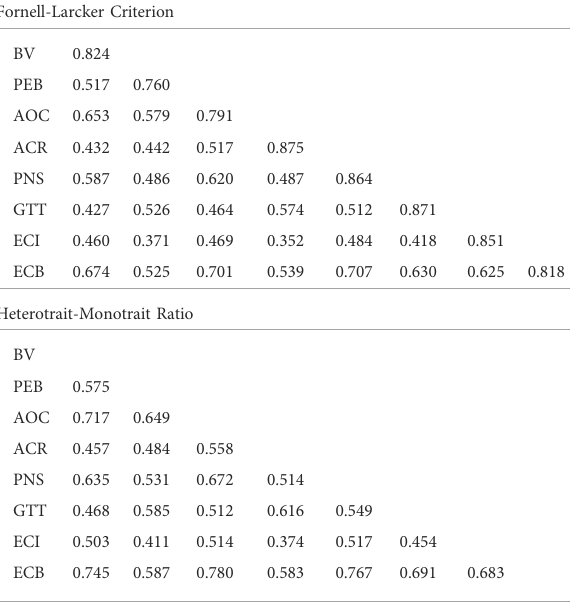
TABLE 4 Discriminant validity. BV PEB AOC ACR PNS GTT ECI ECB Fornell-Larcker